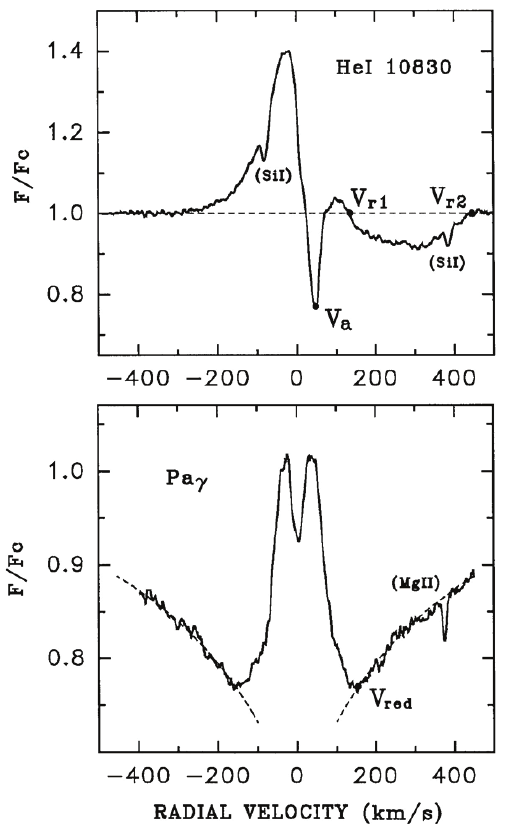
Figure 2. Typical profiles of the NIR CS lines He I λ 10830 and Pa γ in the spectrum of HD101412 shown in [18]. Parameters of the profiles used in the quantitative analysis are indicated. Credit: Schöller et al., A&A, 592, A50, 2016, reproduced with permission ©